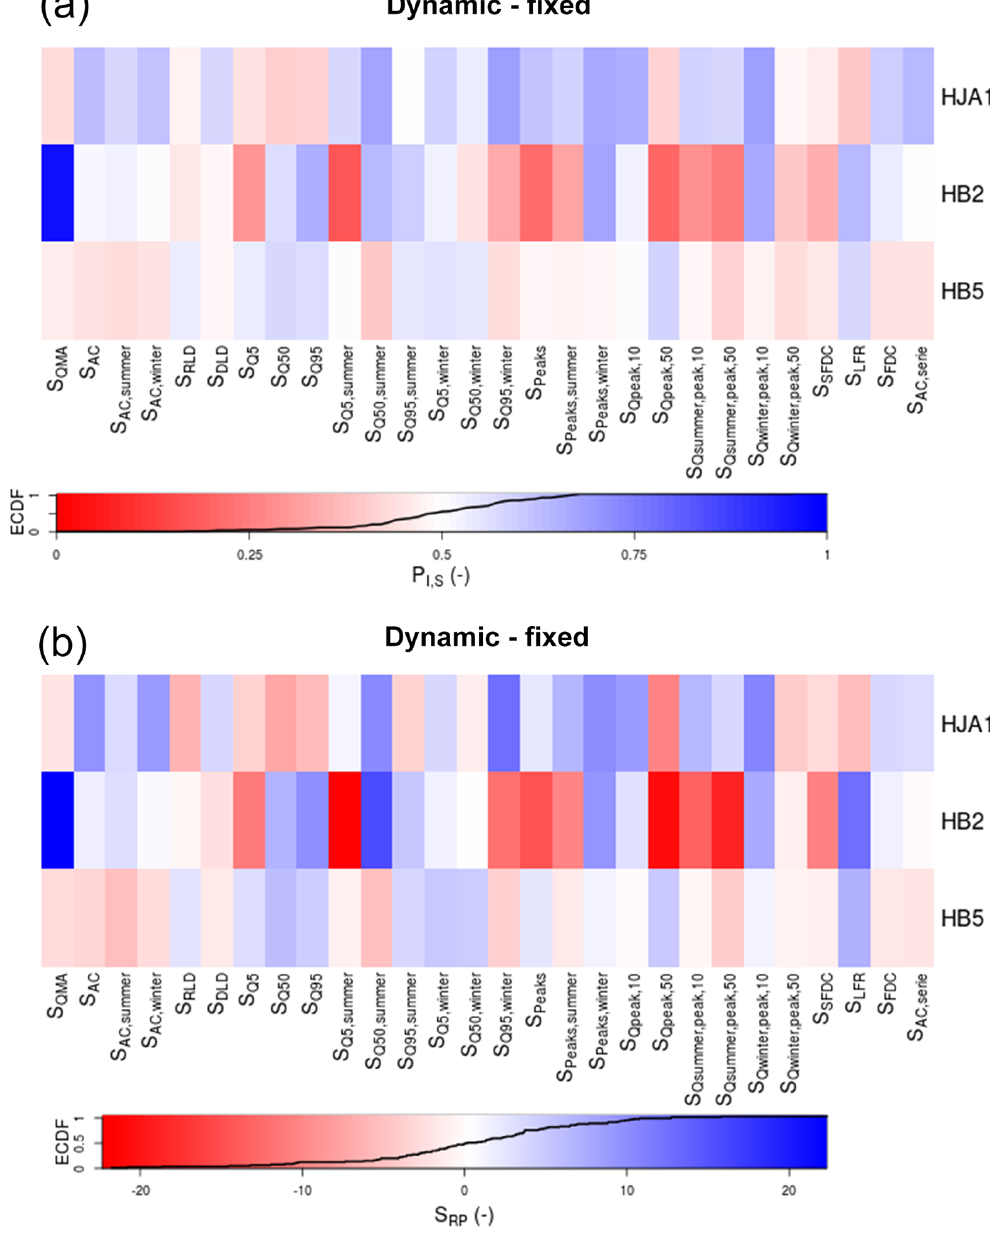
Figure 9. Signature comparison between a time-dynamic and time-invariant formulation of root-zone storage capacity in the FLEX model with (a) probabilities of improvement and (b) Ranked Probability Score for 28 hydrological signatures for HJ Andrews WS1 (HJA1), Hubbard Brook WS2 (HB2) and Hubbard Brook WS5 (HB5). High values are shown in blue, whereas a low values are shown in